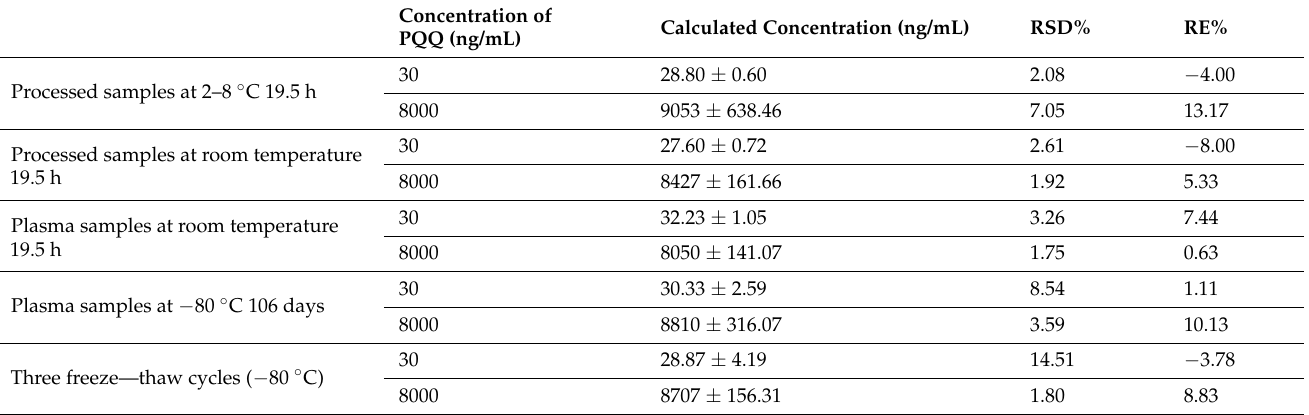
Table 4. Stability of PQQ in rat